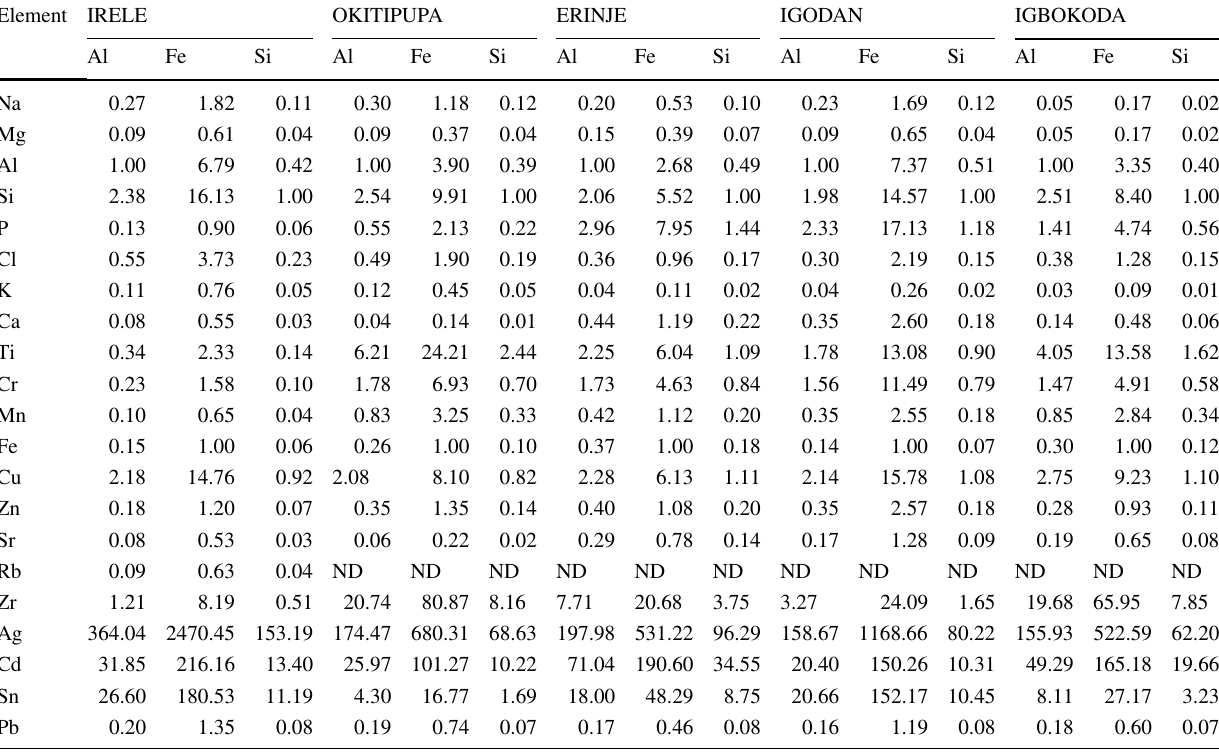
Table 6 Enrichment values using aluminum, iron and silicon as reference elements in all the locations